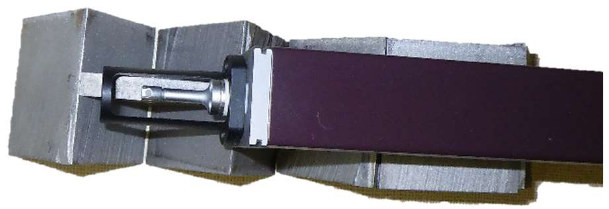
Figure 5. Surftest SJ-301 device measuring the roughness of the cut